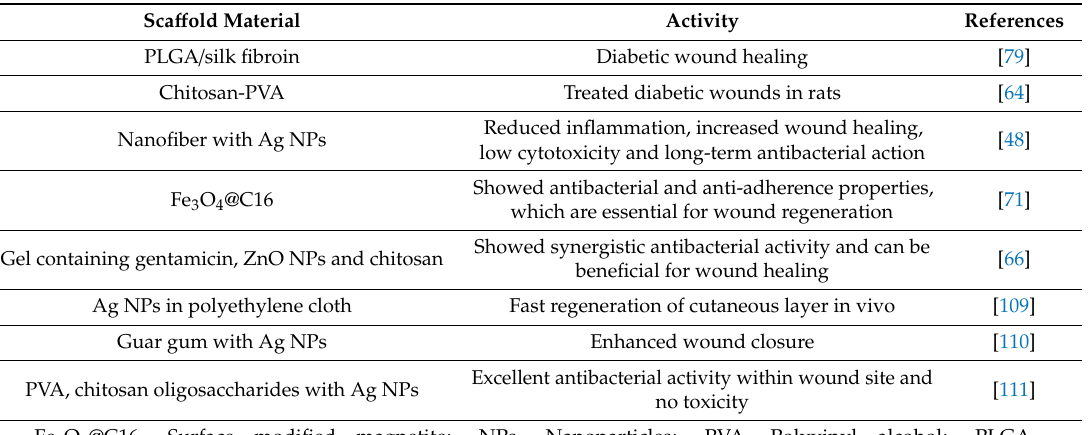
Table 3. Nanomaterial-based sca ff olds for wound